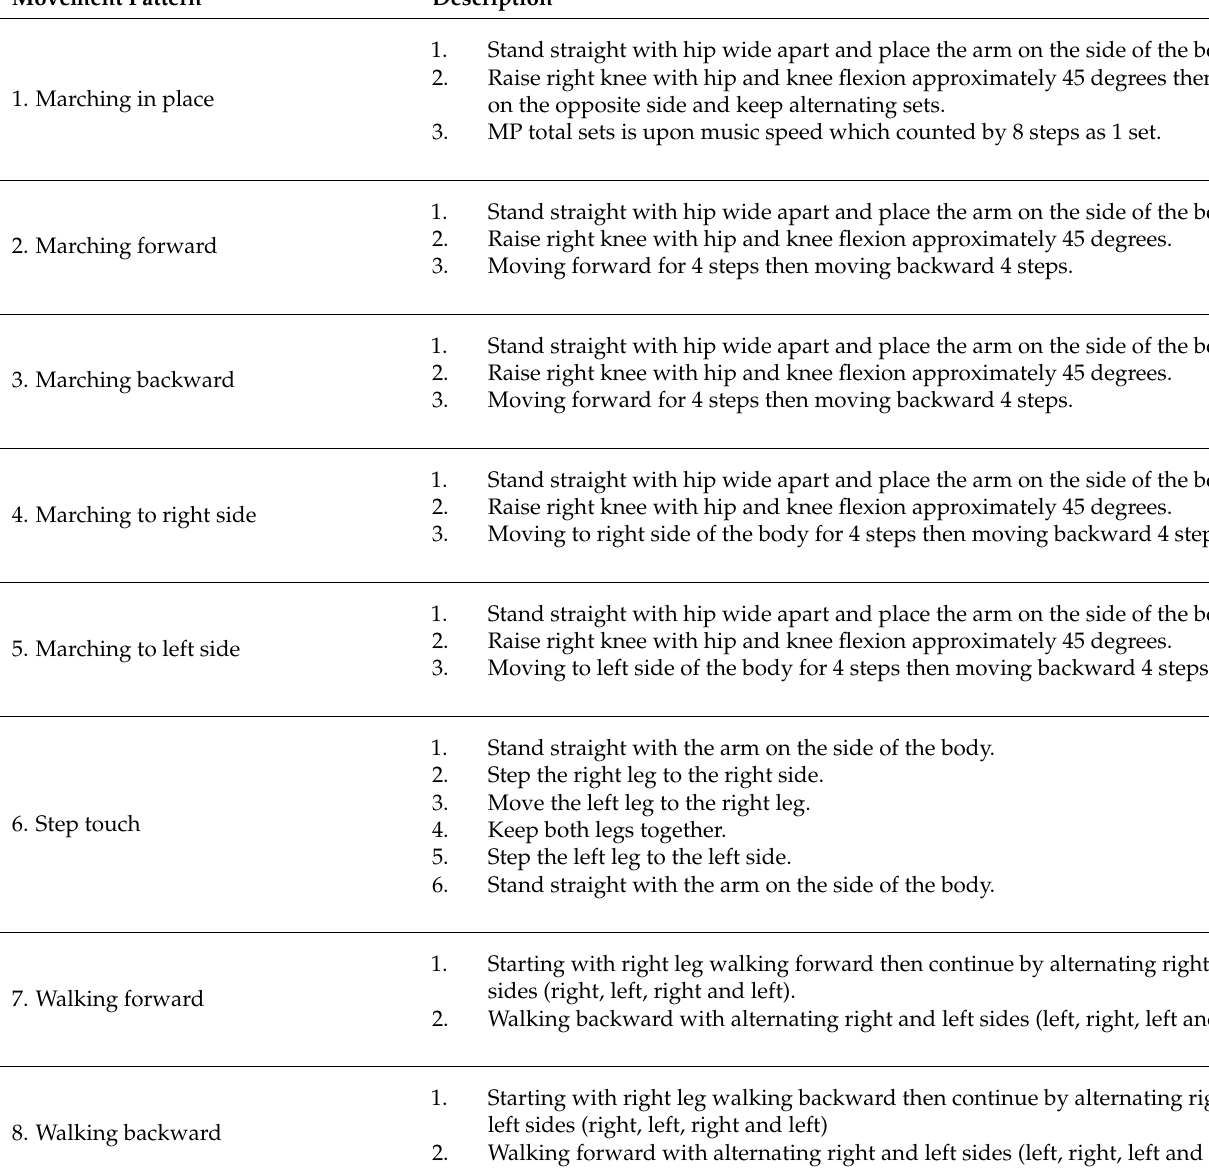
Table A1. Progressive step marching exercise